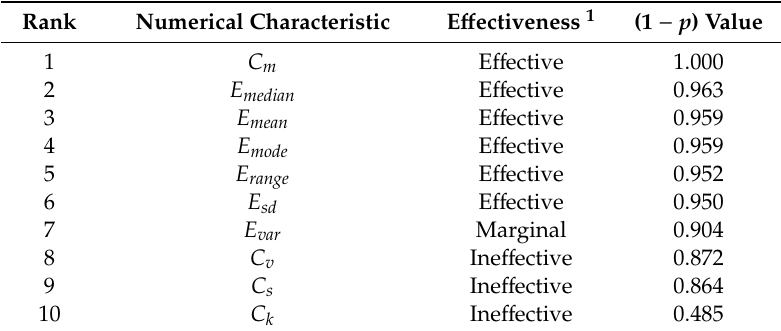
Table 2. Feature selection of numerical characteristics of energy consumption data in terms of recognizing constant / variable-speed ME.